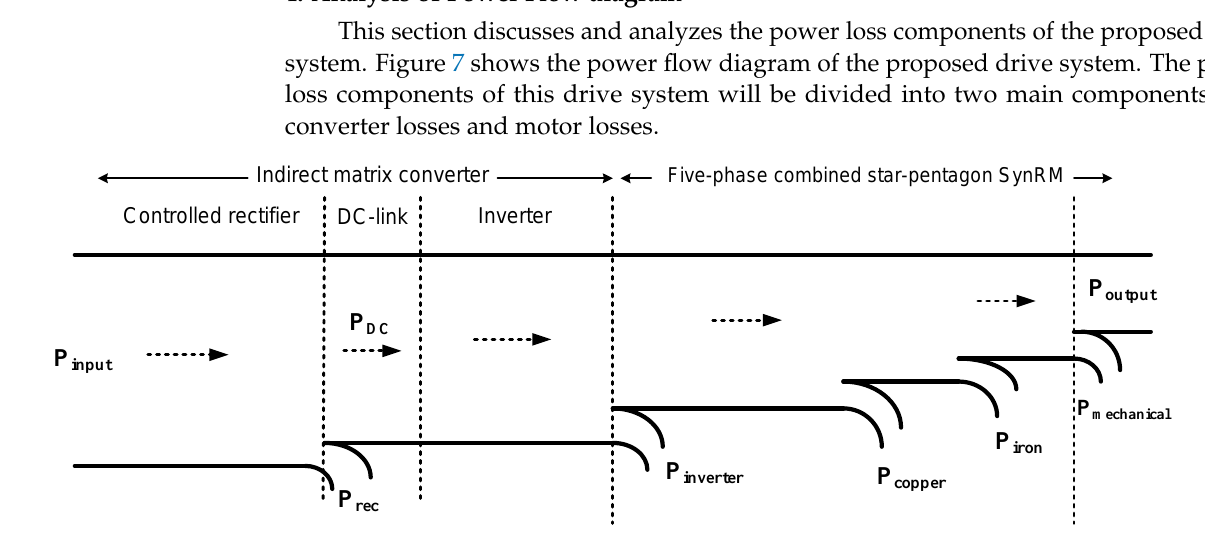
Figure 7. The power flow diagram of the Five-phase SynRM drive system based on indirect MC.